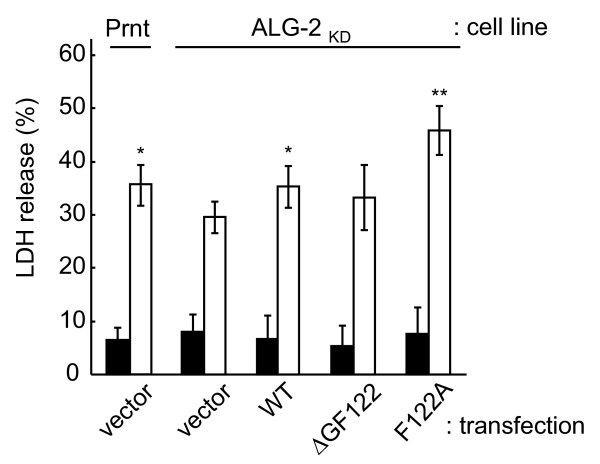
Augmentation of staurosporine-induced cell death by ALG-2F122A. Parental (Prnt) HeLa cells and ALG-2-knockdown (ALG-2KD) HeLa cells were transfected with a vector (pcDNA3) as controls. ALG-2KD cells were transfected with plasmids that express wild-type ALG-2, ALG-2ΔGF122 or ALG-2F122A and cultured for 24 h. The transfected cells were treated with 1 μM staurosporine for 24 h. Cell death was monitored by measuring the amounts of lactate dehydrogenase (LDH) released into the culture medium as described in Materials and Methods. Total amounts of LDH released into the medium and retained in cells were expressed as 100%. Duplicate assays of five independent repetitive experiments were performed and data are presented as means +/- SD (n = 5). Closed column, not treated with staurosporine; open column, treated with staurosporine. Statistically significant differences among staurosporine-treated cells were evaluated by Student's t-test by comparing the measured values of samples with those of control ALG-2KD cells that were transfected with a control vector (*, P < 0.05; **, P < 0.01)